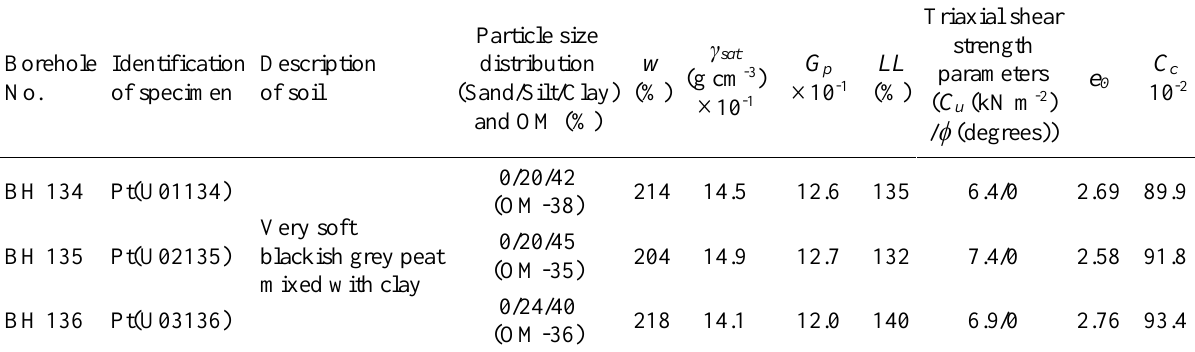
Table 1. Index and engineering parameters of peat used for dynamic (Bender element and cyclic triaxial) tests. OM = organic matter, w = water content, γ sat = saturated density, G p = specific gravity, C u = cohesion, Ø = angle of internal friction, e 0 = initial void ratio, C c = coefficient of consolidation.